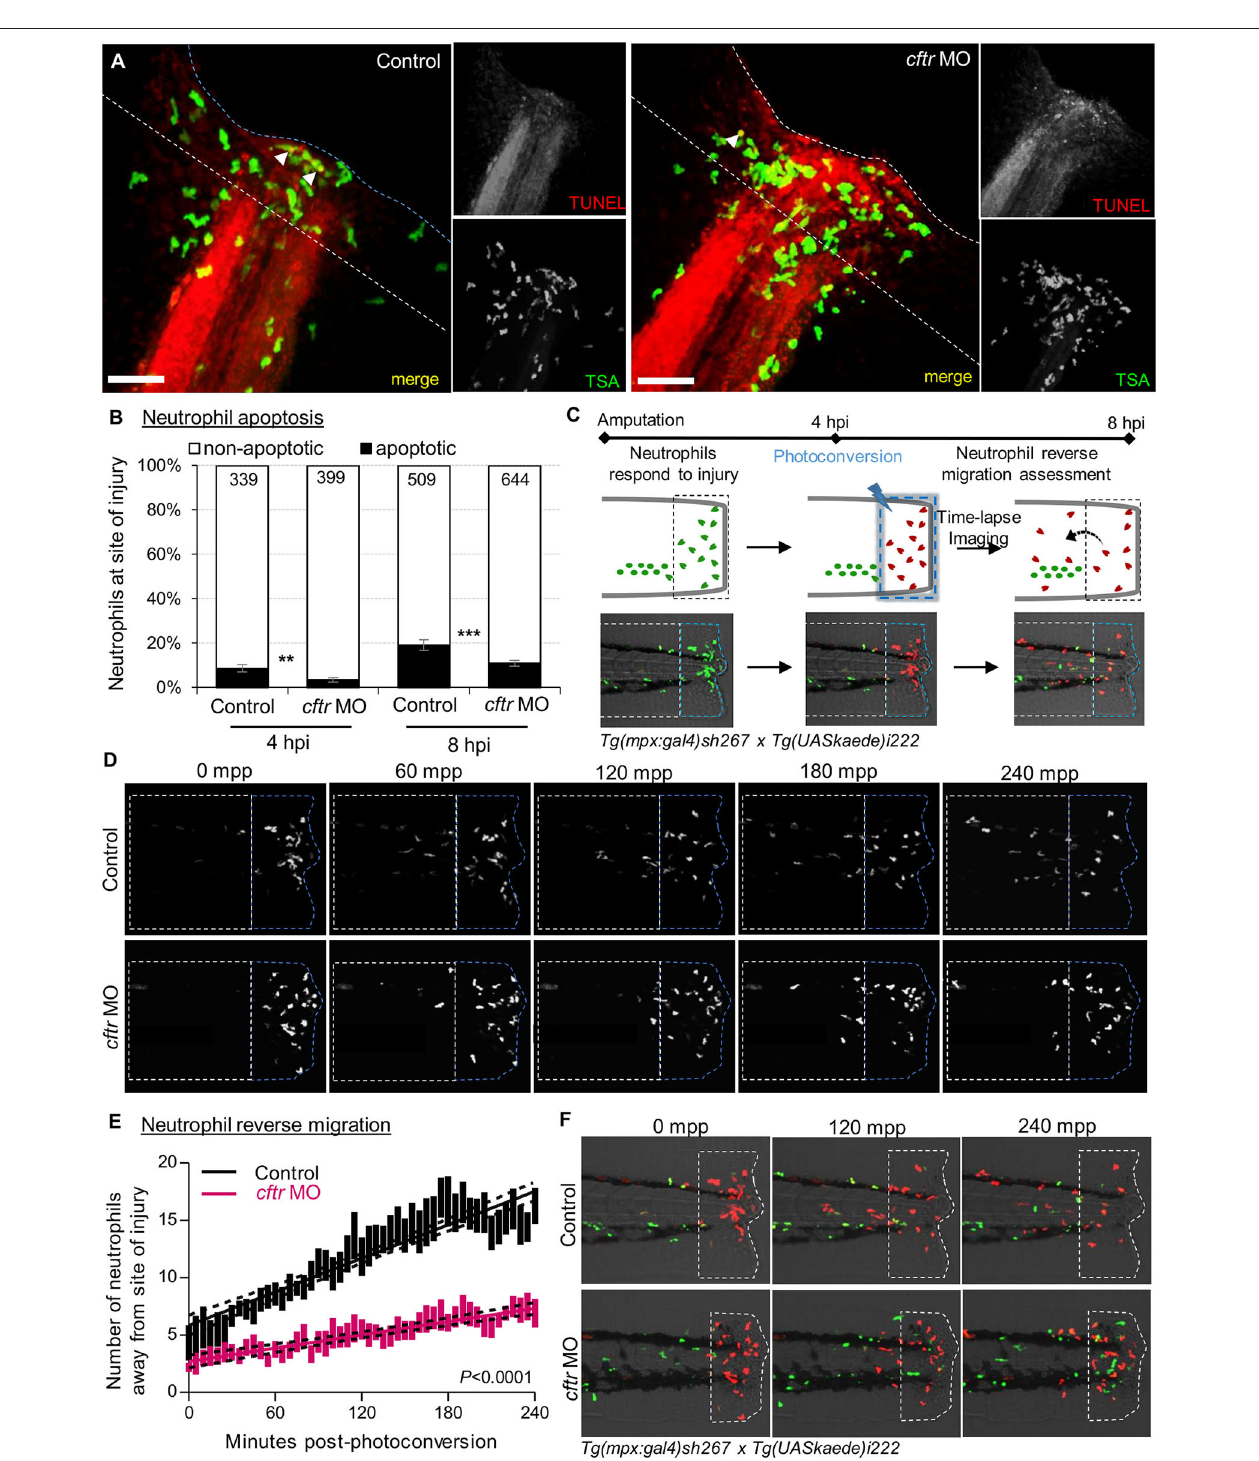
FIGURE 3 | CFTR deficiency delays inflammation resolution in vivo both by reducing neutrophil apoptosis and reverse migration of neutrophils. (A,B) C ontrol and cftr MO larvae were amputated and stained with TUNEL/TSA to label apoptotic cells. (A) Representative confocal pictures of injured tails at 8 hpi (scale bars, 60 µ m) revealing the proportion of apoptotic neutrophils at the wound (white arrow). (B) Quantification of neutrophil apoptosis rate at site of injury at 4 and 8 hpi. ( n = 18–22, Fisher t -test). (C–F) Neutrophil reverse migration in control and cftr MO larvae. (C) Tail transection was performed on 3 dpf Tg(mpx:gal4)sh267;Tg(UASkaede)i222 larvae. The site of injury was photoconverted at 4 hpi, then the number of photoconverted neutrophils (red) moving away (white dotted box) from the wound